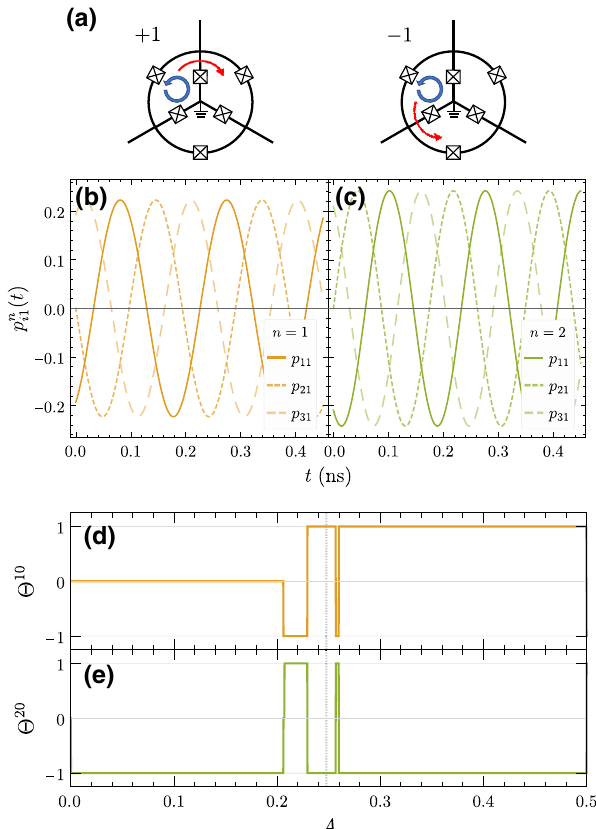
FIG. 3. (a) Schematic of the clockwise or counterclockwise vortex tunneling shown in (b),(e). The linear response of the loop currents in the central circuit due to the presence of a voltage on the first island is shown in (b),(c). The contributions from (b) the first excited state and (c) the second excited state are shown, demonstrating the creation and motion of vortices as a result of an incoming signal at our chosen operating point A ≈ 0.2478. Vortex tunneling is shown in the two-state superpositions of (d) the ground state and first excited state and (e) the ground state and second excited state as a function of A , the flux penetration per loop. As in Fig. 2, the circuit is periodic on A ∈ { 0, 1 } and anti- symmetric about A = 0.5, and hence only 0 ≤ A ≤ 0.5 is shown here. + 1.0 indicates clockwise vortex tunneling, − 1.0 indicates counterclockwise vortex tunneling, and 0 indicates the absence of a vortex. The parameters for these plots are the same as those for Fig.